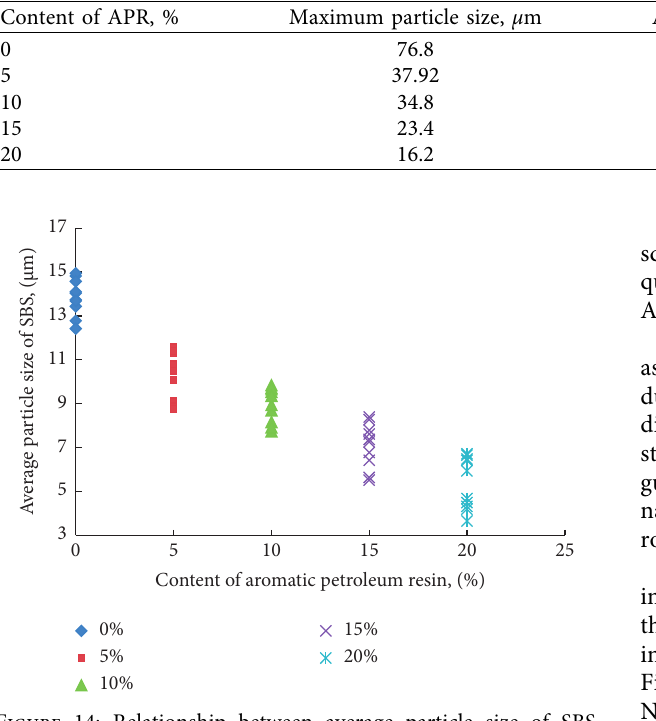
Figure 14: Relationship between average particle size of SBS modifier and content of